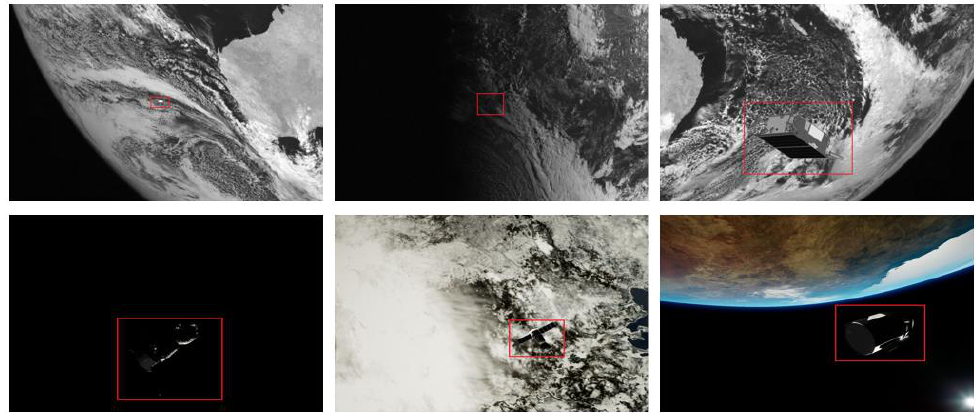
Figure 10. Diagram of hard examples in the dataset. Spacecraft objects are marked with red bound- ing boxes.